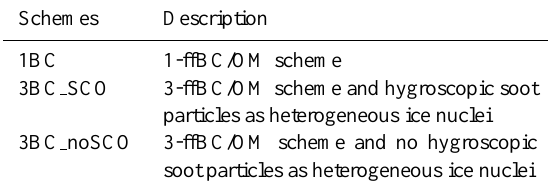
Table 1. Offline